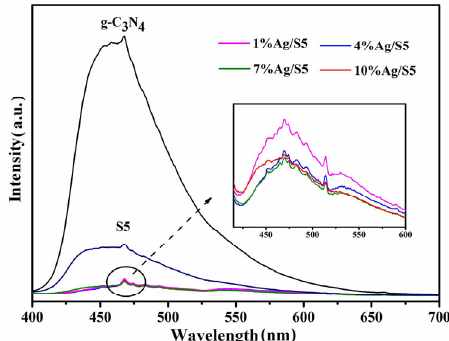
Fig. 6 PL spectra of g-C 3 N 4 , S5, and the ternary Ag/ CeVO 4 /g-C 3 N 4